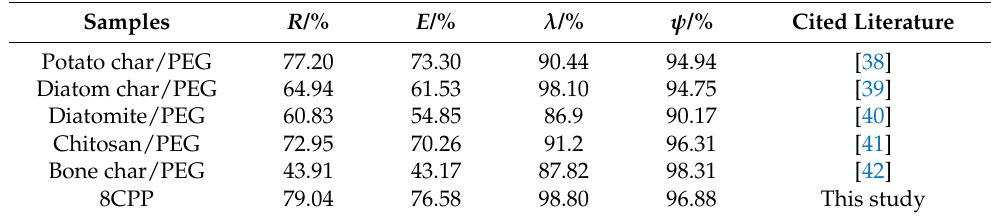
Figure 7. ( a ) R, E, λ , ψ of each composite material; ( b ) the subcooling degree of PEG and each composite material and PEG; ( c ) DSC diagram, and ( d ) FTIR diagram before and after 200 cycles of 8CPP. Table 2. Comparison between the thermal energy storage characteristics of different PEG-based PCMs reported in the literature.